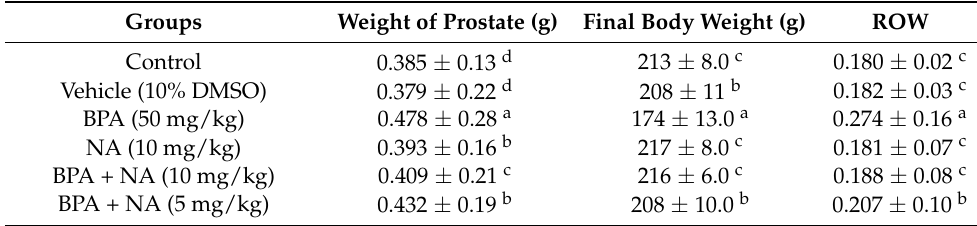
Table 3. Assessment of size, weight, and ROW of prostate. Groups Weight of Prostate (g) Final Body Weight